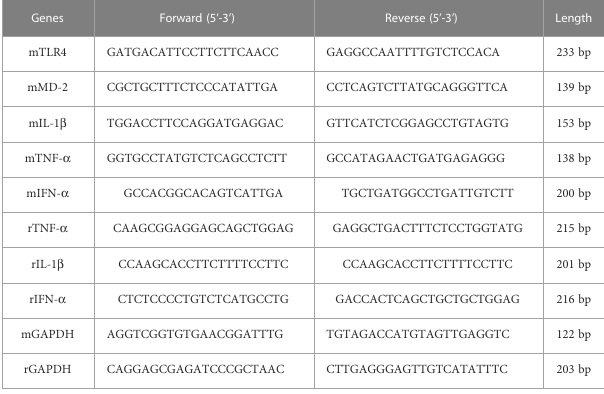
TABLE 3 The sequences for